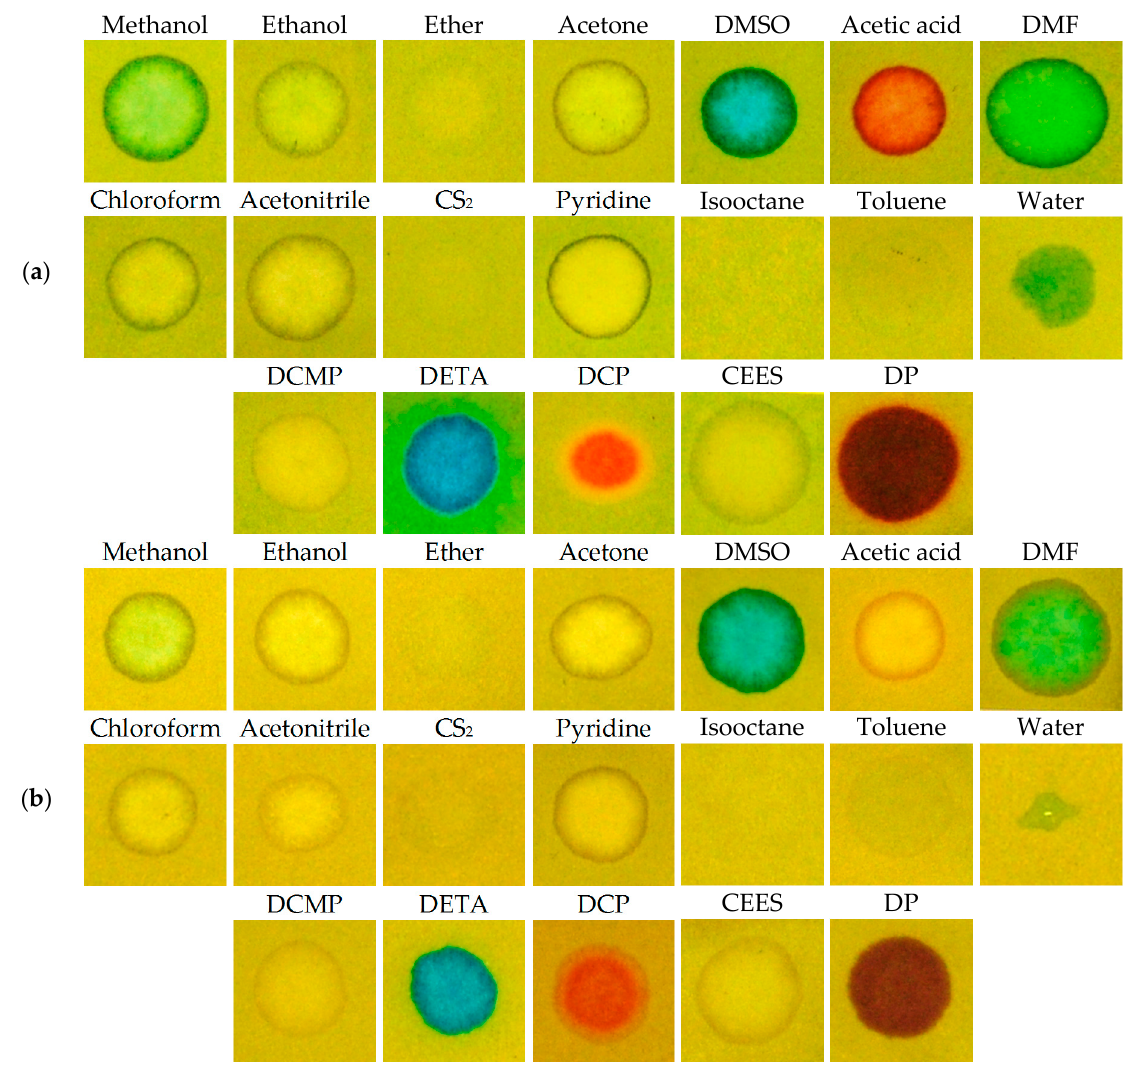
Figure 11. Color response a ) RM1a/PY-OPD/BCG, b ) RM1a/PY-OPD/BCG/colophon to selected